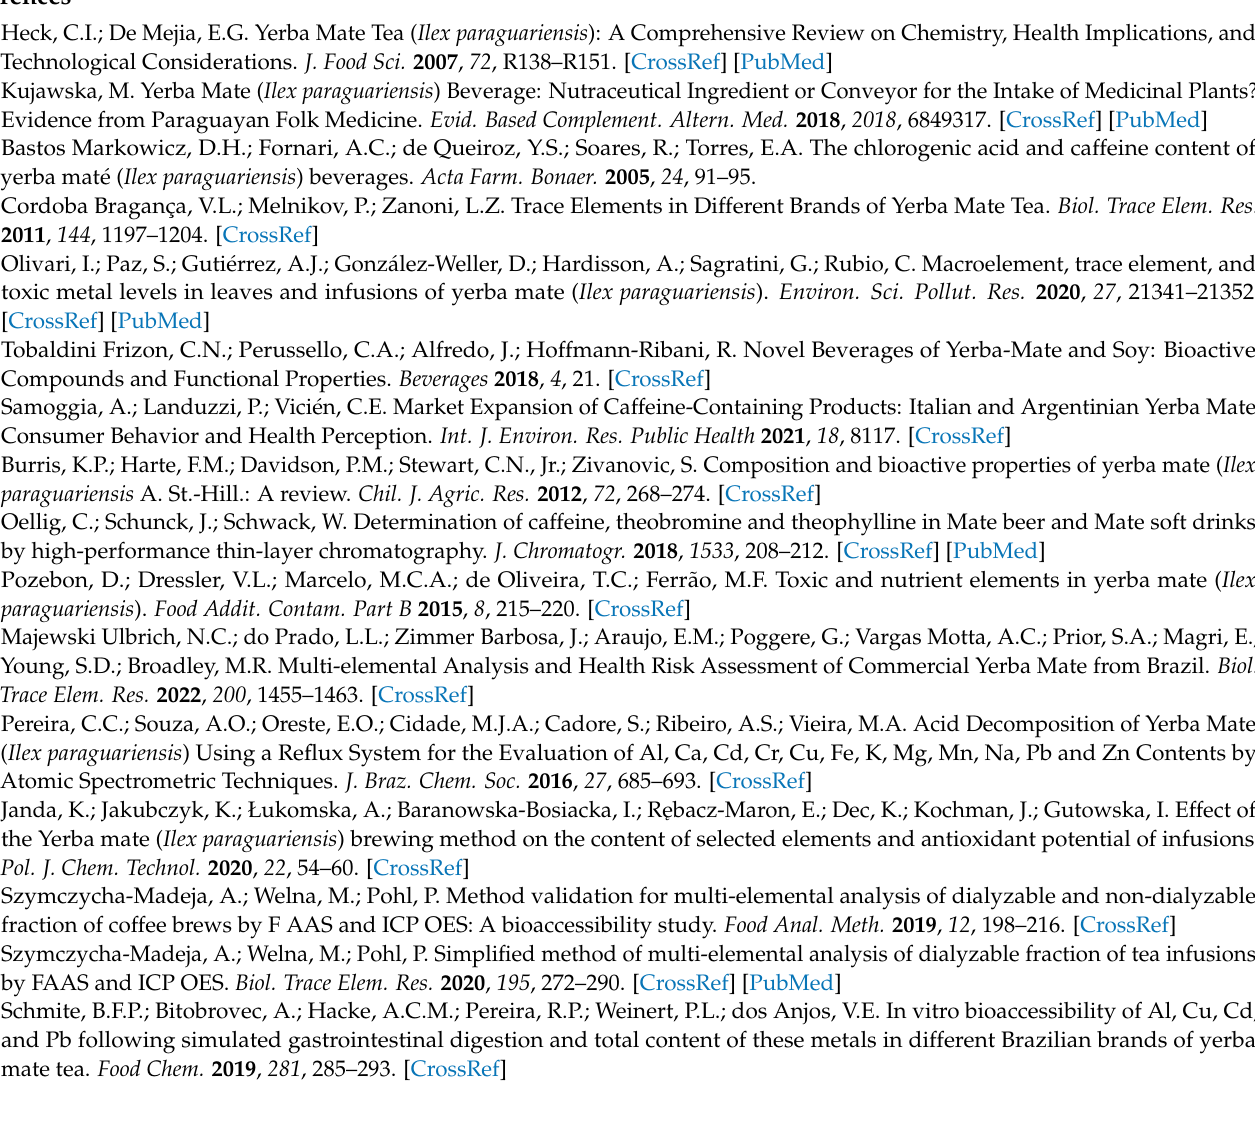
preparation procedures. Table S2: The nutritional value of the analyzed yerba mate (YM) energy drinks